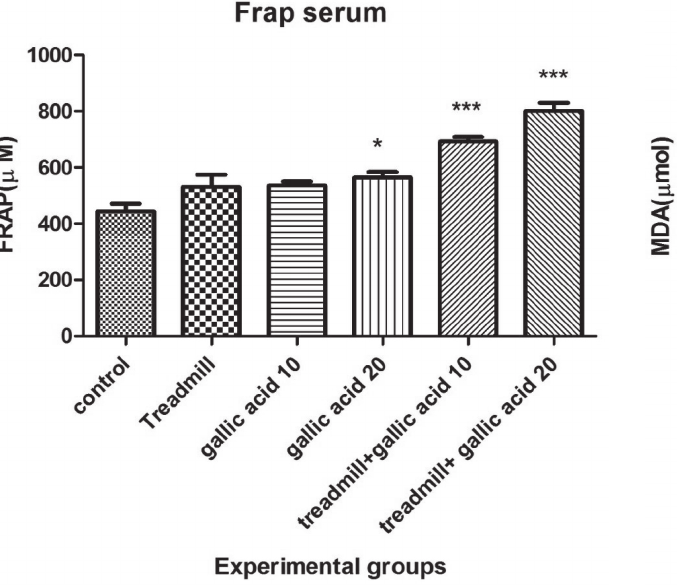
FIGURE 2 - The effects of gallic acid and physical exercise, alone and combined, on serum antioxidant capacity; * = ( p <0.05); *** ( p <0.001).